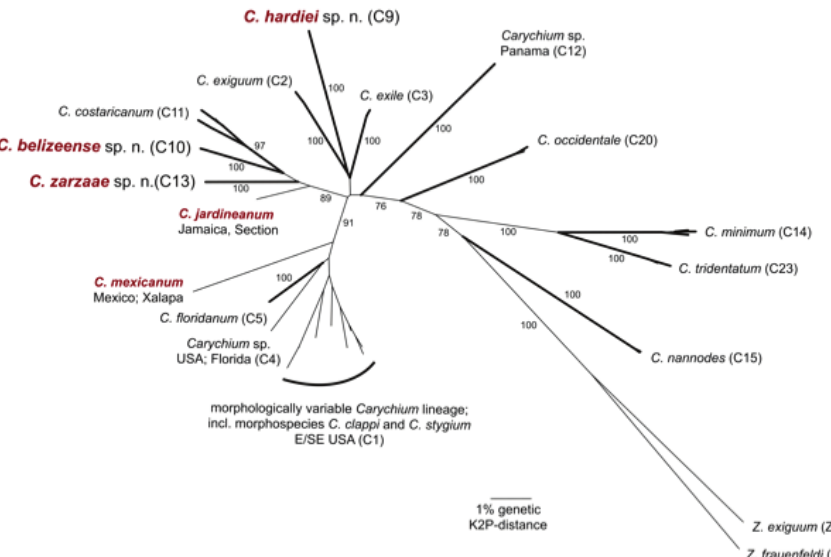
Figure 3. Neighbor-Joining overview topology based on COI K2P-distances for all North and Central American evolutionary lineages accessed in Weigand et al. (2013) and the three newly described Cary- chium species. COI data for C. mexicanum and C. jardineanum are added. Numbers at the branches indi- cate bootstrap support for the lineages. BOLD-IDs: Carychium lineage C1, E / SE USA: BARCA014-10